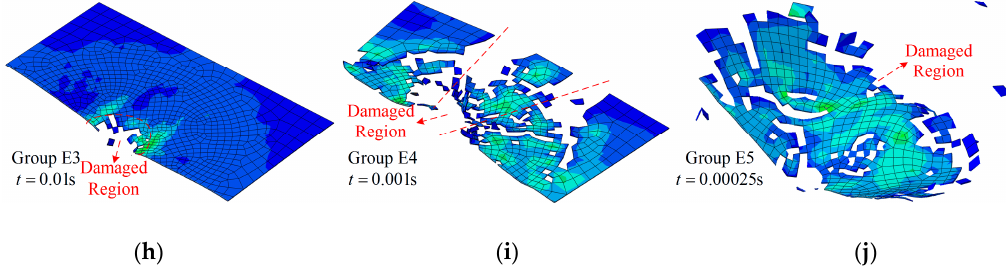
Figure 15. The fracture morphology of the top layer with different frequencies: ( a ) Group D1; ( b ) Group D2; ( c ) Group D3; ( d ) Group D4; ( e ) Group D5; ( f ) Group E1; ( g ) Group E2; ( h ) Group E3; ( i ) Group E4; ( j ) Group E5.